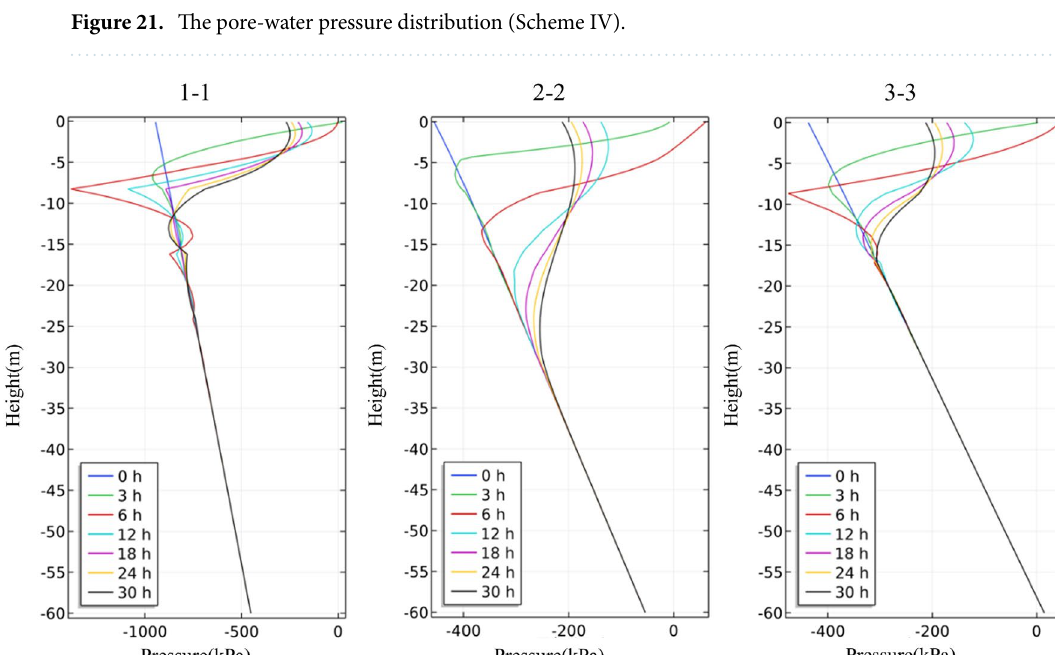
Figure 22. The variation of pore-water pressure in characteristic profiles(Scheme